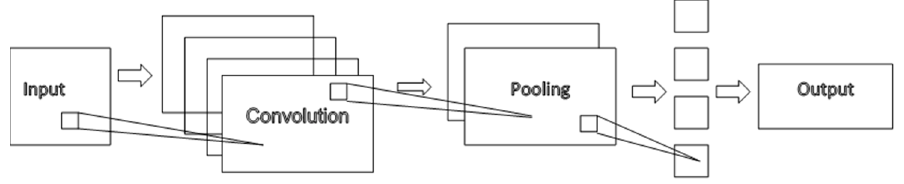
Figure 3. Convolutional neural network (CNN) architecture [21] .